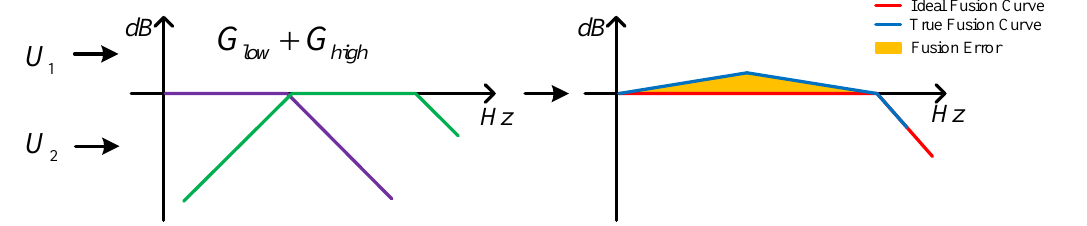
Figure 1. Fusion process of sensor signals in the frequency domain.